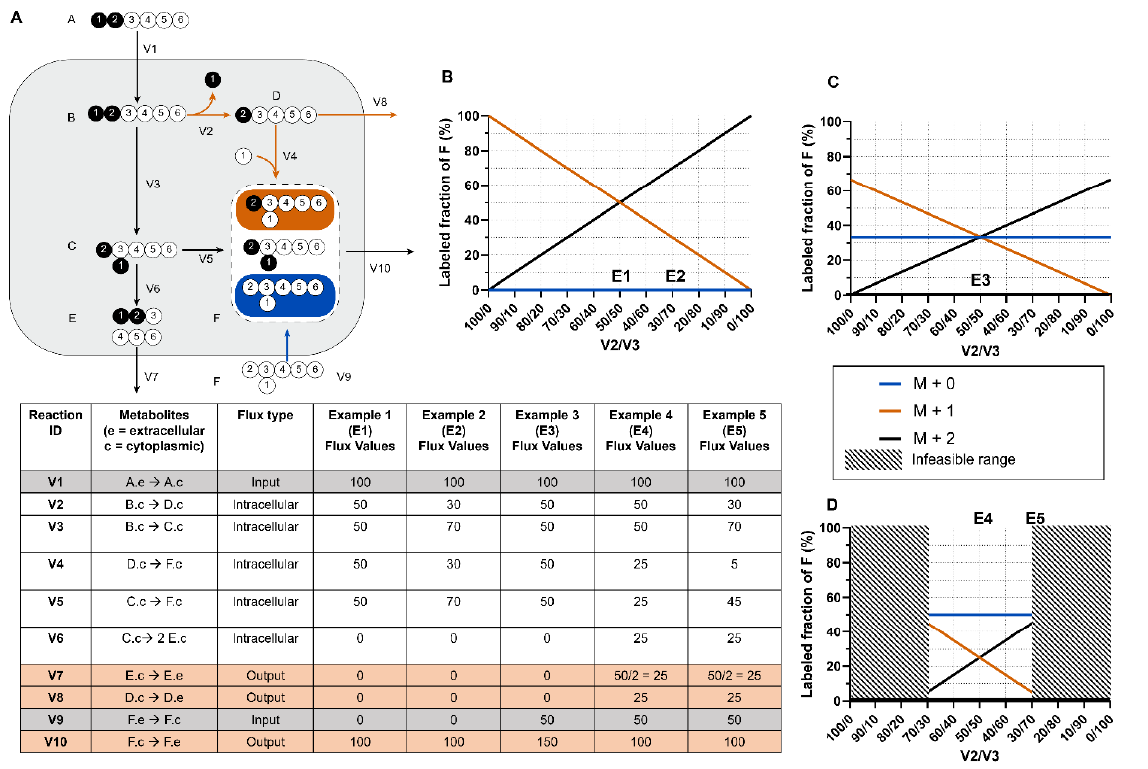
Figure 2. Metabolite MDVs are flux-weighted averages of precursor substrate MDVs. ( A ) A toy model of a metabolic system with two input fluxes, three output fluxes, and five irreversible forward reactions. The corresponding reaction information and flux values for examples are shown in the table below. Note that the measured flux of V7 must be divided by 2 when calculating the amount of C consumed to properly account for reaction stoichiometry. ( B ) The relationship between V2/V3 flux values and metabolite F isotopomers in the scenario where V1 and V10 are the only non-zero fluxes. In these examples, [M+1] and [M+2] are the only possible isotopomers of F. ( C ) The relationship between V2/V3 flux values and metabolite F isotopomers when V9 is non-zero. Possible isotopomers [M+0], [M+1], and [M+2] due to influx of unlabeled F. The influx of unlabeled F dilutes the labeled pool of [M+1] and [M+2]. ( D ) Scenario where V7 and V8 fluxes are both non-zero, which also mandates non-zero fluxes in V2 and V3. This further narrows the range of possible flux values for V2 and